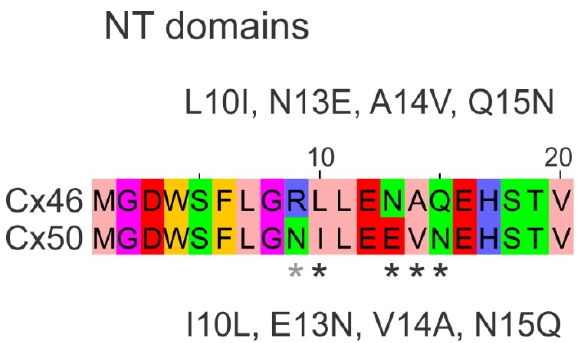
Figure 1. Amino acid sequence alignment of Cx46 and Cx50 amino terminal domains. The first 20 amino acid residues of the amino terminal (NT) domains of Cx46 and Cx50 are aligned. A total of 5 out of 20 residues are different as indicated by asterisks (black and grey). Our designed missense variants are listed next to their parental connexin. A grey asterisk on the ninth position indicates that both Cx46 N9R and Cx50 R9N were studied earlier [38].